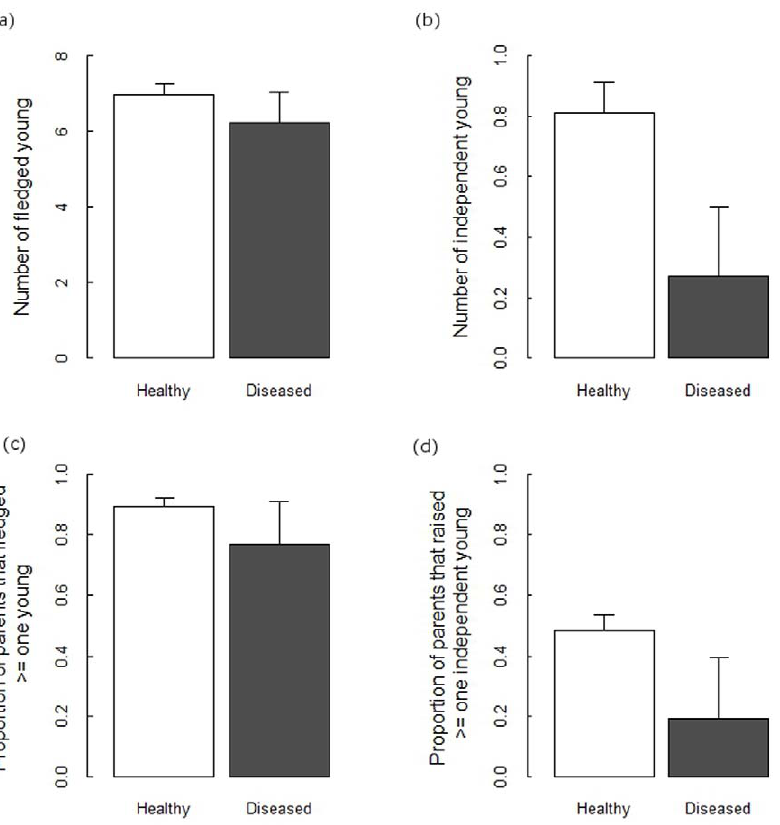
Figure 1. Reproductive performance measures for healthy and diseased great tit pairs at Wytham Woods. (a) average number of young fledged; (b) average number of independent young raised; (c) the proportion of pairs with at least one fledged young; (d) the proportion of pairs raising at least one independent young. Shown are the average estimates from the raw data ( 6 95% CI).